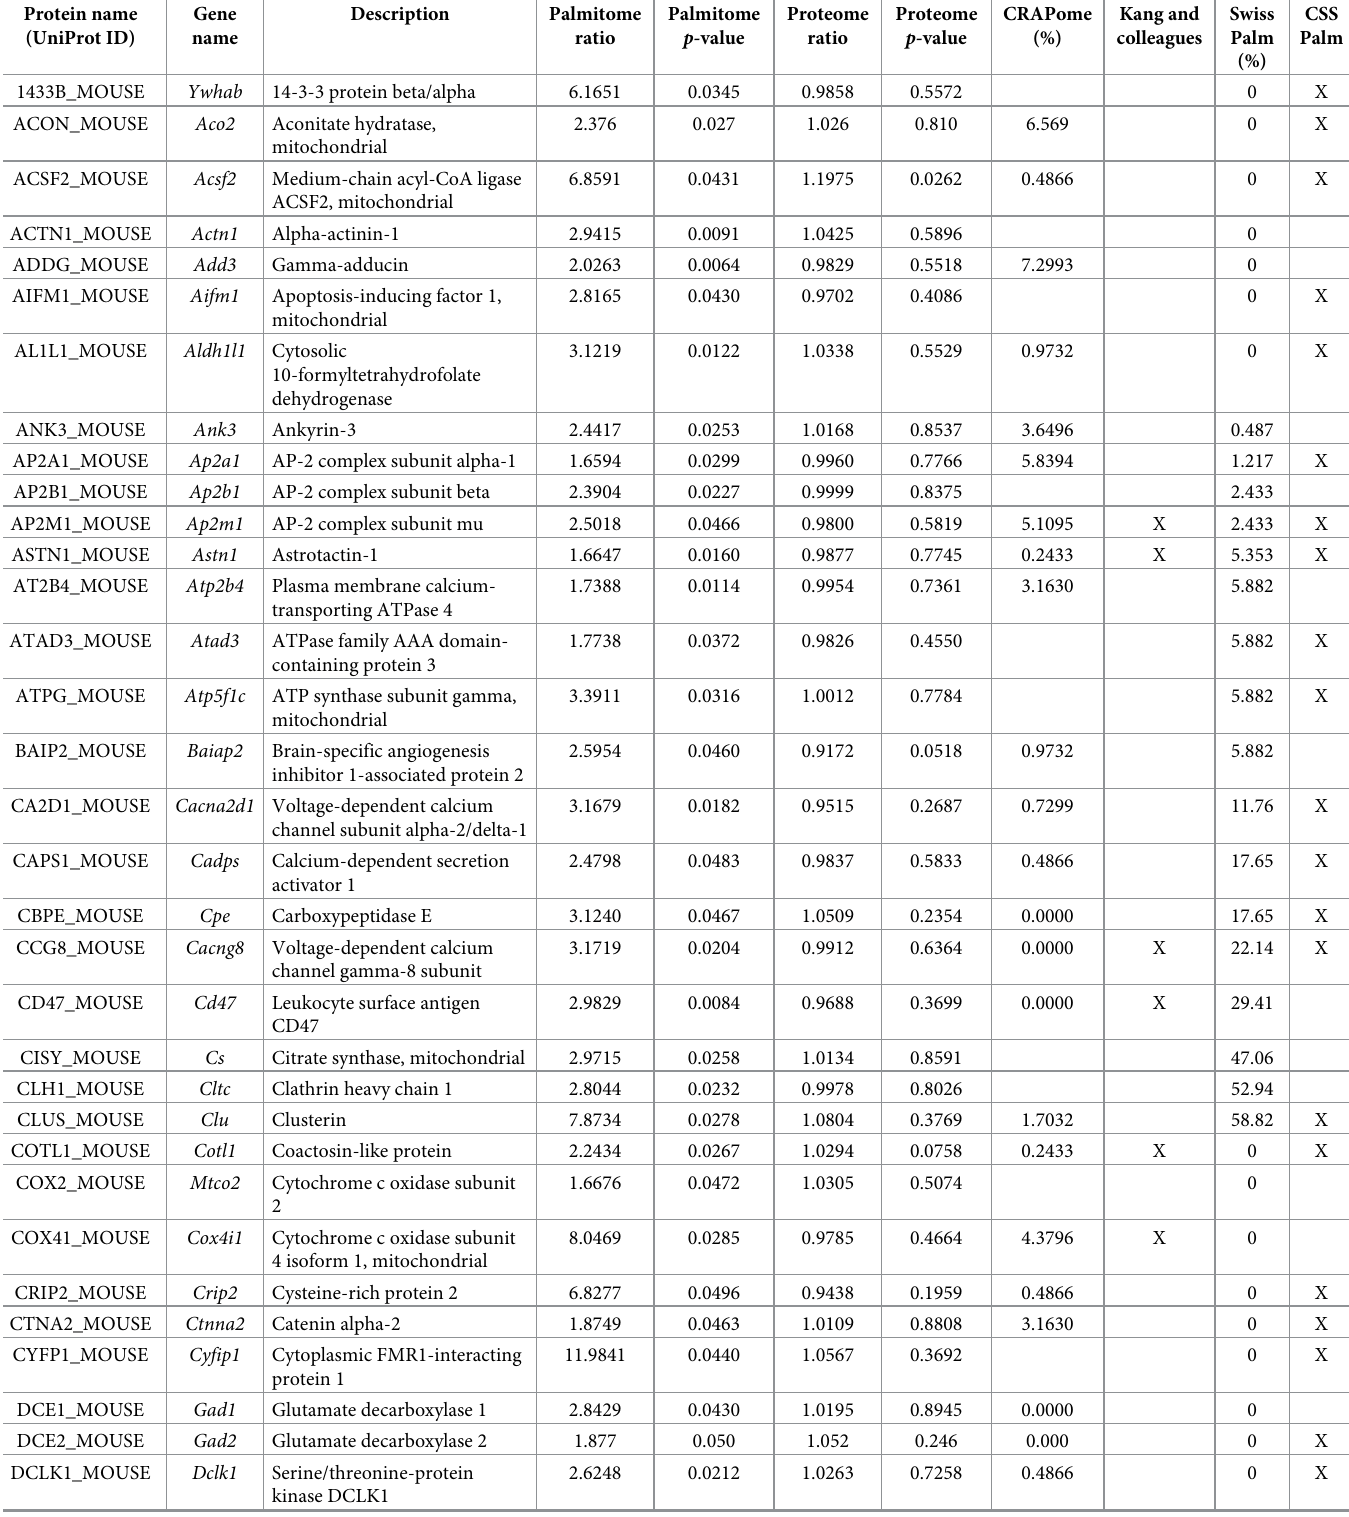
Table 2. Medium-confidence validated PPT1